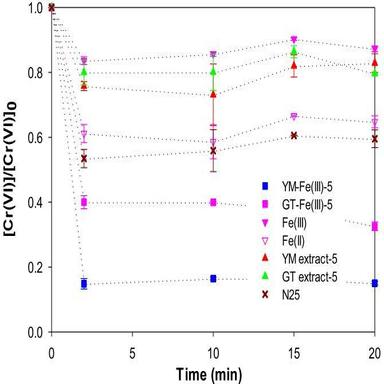
Temporal evolution of the normalized Cr(VI) concentration after 20 min of contact with YM-Fe(III)-5, GT-Fe(III)-5, N25, Fe(III), Fe(II) controls at Cr (VI):Fe MR = 1:0.5, and controls with YM extract-5 and GT extract-5. Conditions: 0 = 300 μM, pH 3.